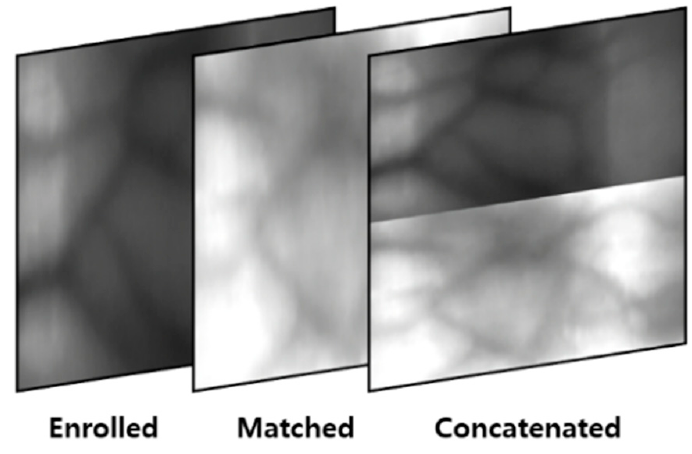
Figure 5. Example of composite image.